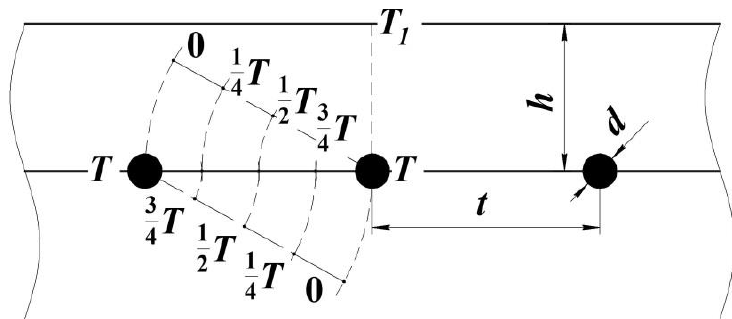
Figure 3. Shaping surface with internal heat sources.